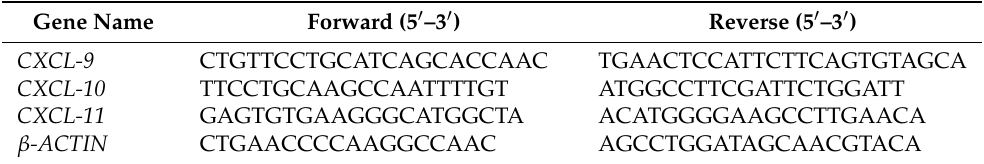
Table 1. Sequences of primers for RT-PCR